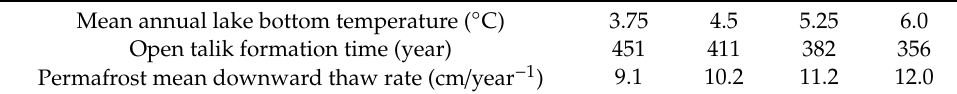
Table 2. The open talik formation times and corresponding permafrost mean downward thaw rates below thermokarst lakes with di ff erent mean annual lake bottom